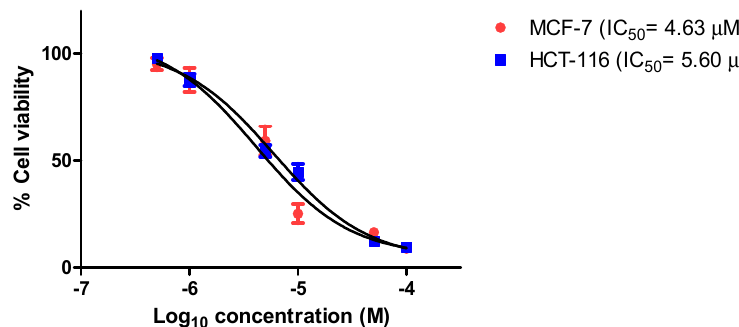
Figure 3. Anti-proliferative effect of 4c in MCF-7 and HCT-116 cells. Cells were grown in 96-well and treated with 4c at 0.1 µ M to 100 µ M for 72 h. Cell viability was expressed as a percentage of vehicle plates and treated with 4c at 0.1 µM to 100 µM for 72 h. Cell viability was expressed as a percentage of vehicle control [ethanol 0.1% (v/v)] treated cells. The values represent the mean ± S.E.M. for three experiments performed in triplicate. independent experiments performed in triplicate.